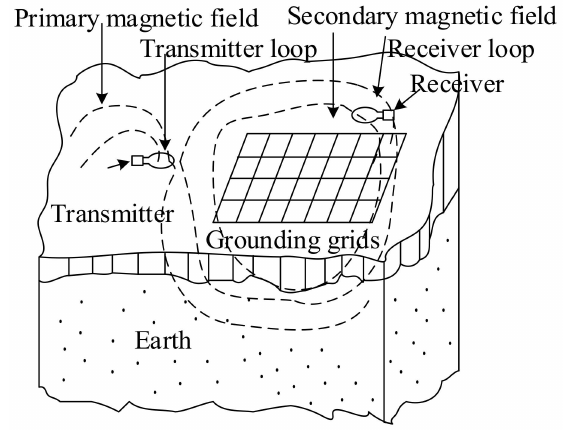
Figure 2. A Schematic field setup of transient electromagnetic method [46].